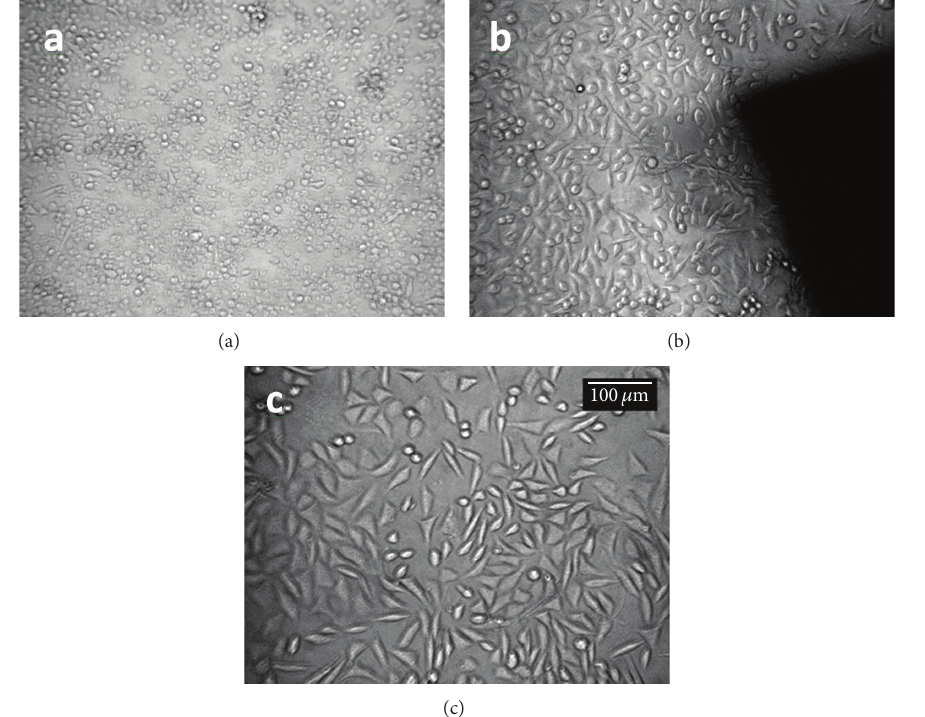
Figure 5: L929 cells incubated with (a) positive control, (b) negative control, and (c) 50:50 blend of TPU:PDMS containing 5pbw of compatibilizer over 24